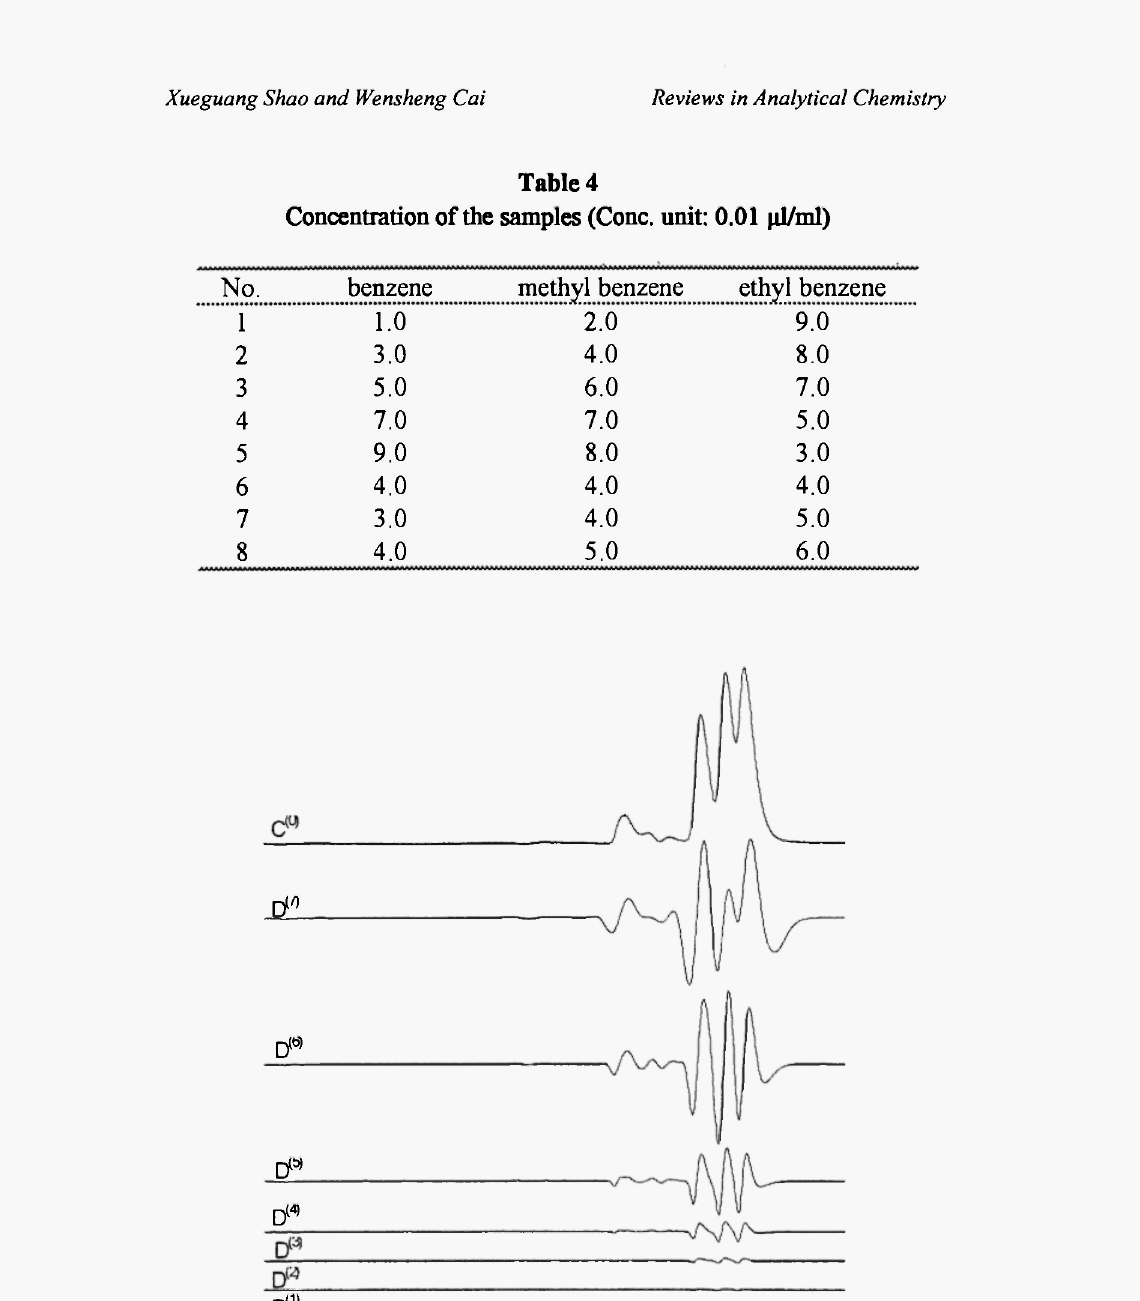
Fig. 28: Discrete details obtained by the on-line wavelet transform from the chromatogram of sample No.